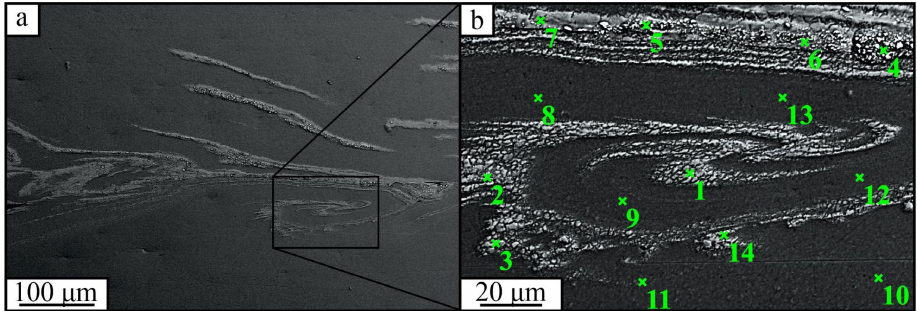
Figure 10. SEM image the IMCs intermixed with the stir zone ( a ) and enlarged view of these IMC structures with the EDS probe zones numbered from 1 to 14 ( b ), whose EDS spectra are identified in Table 3 below. Table 3. The EDS element compositions of the FSW TiAl64V stir zone in points as shown in Figure 10.